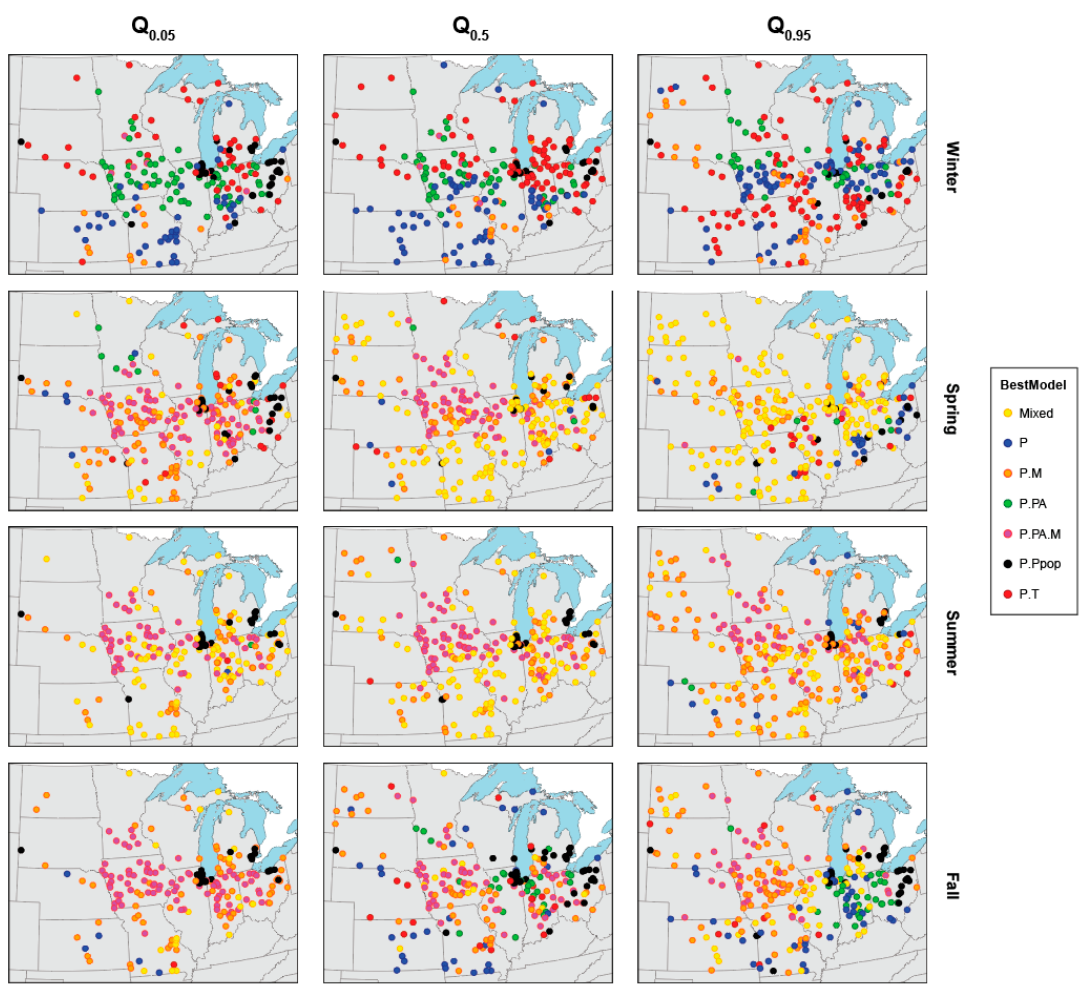
Figure 6. Best-fitting model, by quantile and season. Colored circles indicate the best-fitting model based on the smallest AIC for all of the models that were fit at every site. Rows indicate the four seasons (winter, spring, summer and fall), and columns the three selected flow quantiles for low, median and high flow ( Q 0.05 , Q 0.5 , and Q 0.95 ). The models are indicated as: yellow ( Mixed model), blue ( P ), orange ( P . M ), green ( P . PA ), magenta ( P . PA . M ), black ( P . Ppop ) and red ( P . T ). For maps of the best-fitting models for every one of the 21 flow quantiles and for every season, see Figure S3.